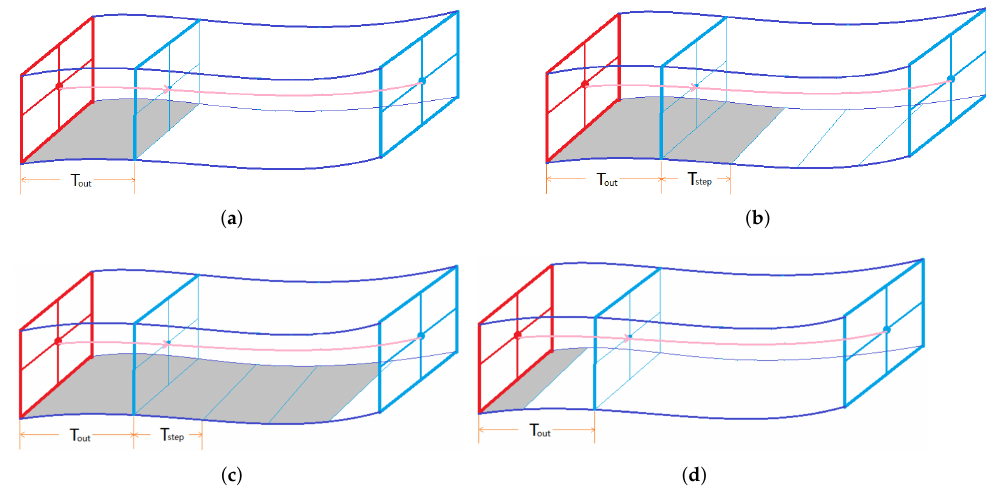
Figure 11. Illustration of output procedure for descriptors embedded in a 3D space–time volume aligned with a